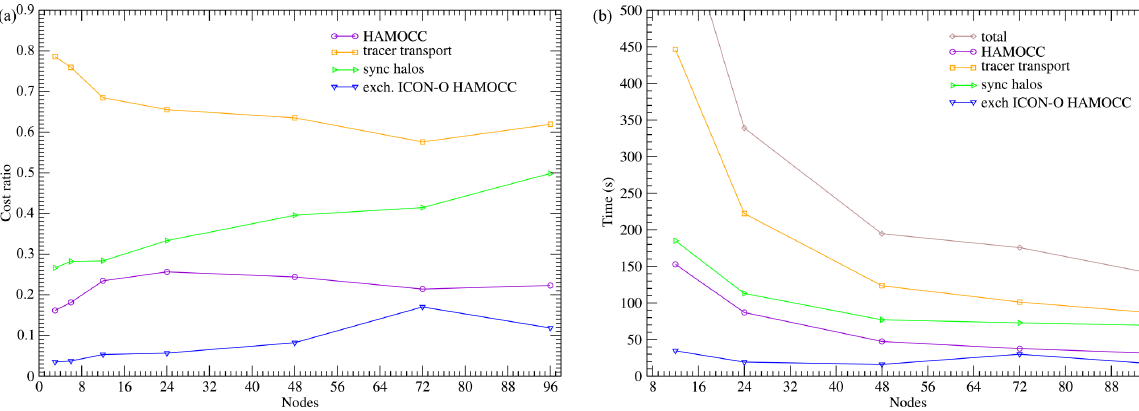
The relative costs and times for ICON-O and HAMOCC in the concurrent setup are given in Figs. 15 and 16